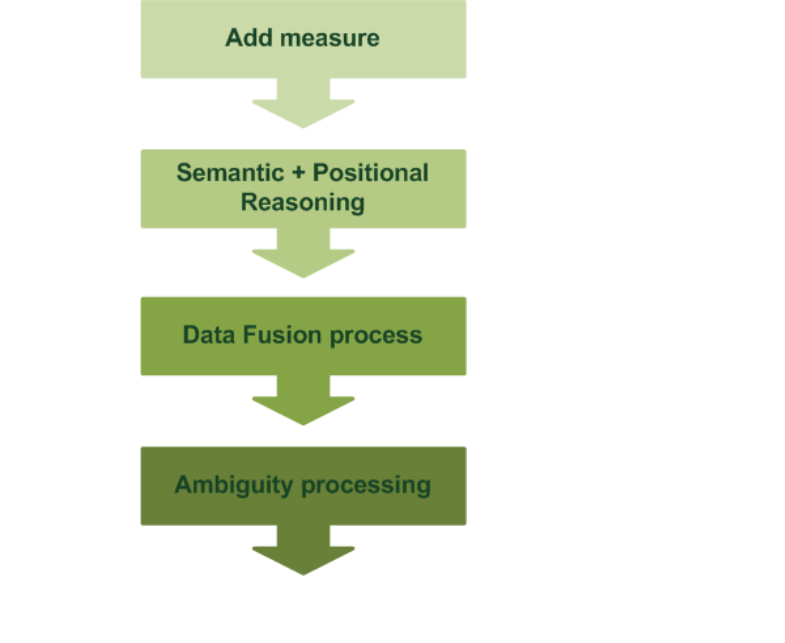
Figure 3. Context management